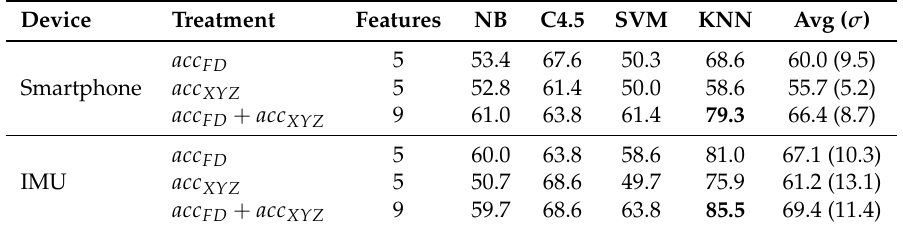
Figure 4. Comparison of classification results using smartphone and IMU data from Table 1. Table 1. Correctly classified instances (%) using acceleration data from smartphone and IMU. NB: Naive Bayes; SVM: Support Vector Machines; and KNN: K-Nearest Neighbors.